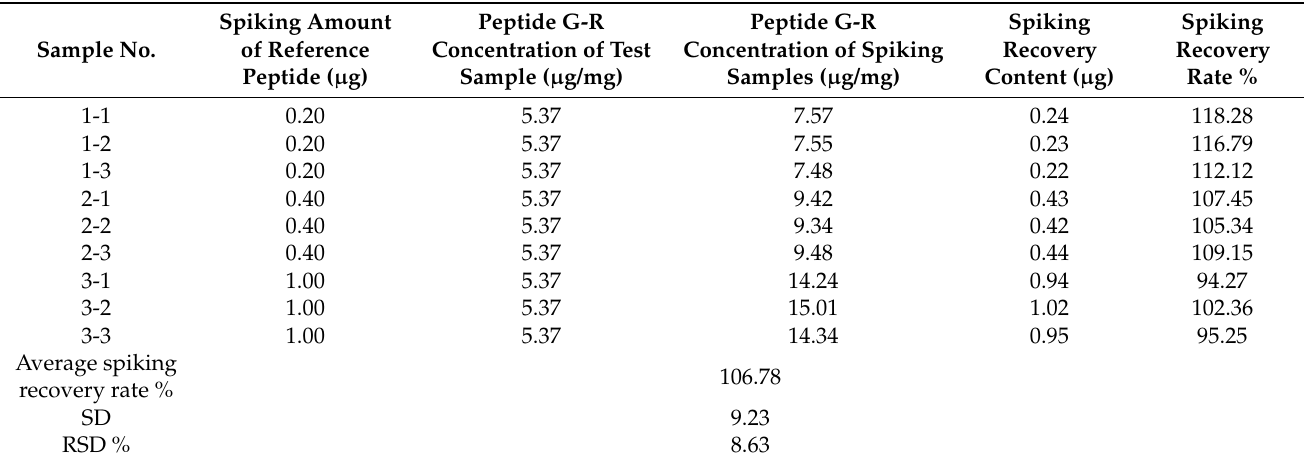
Table 4. Spiking recovery rate of quantification method.